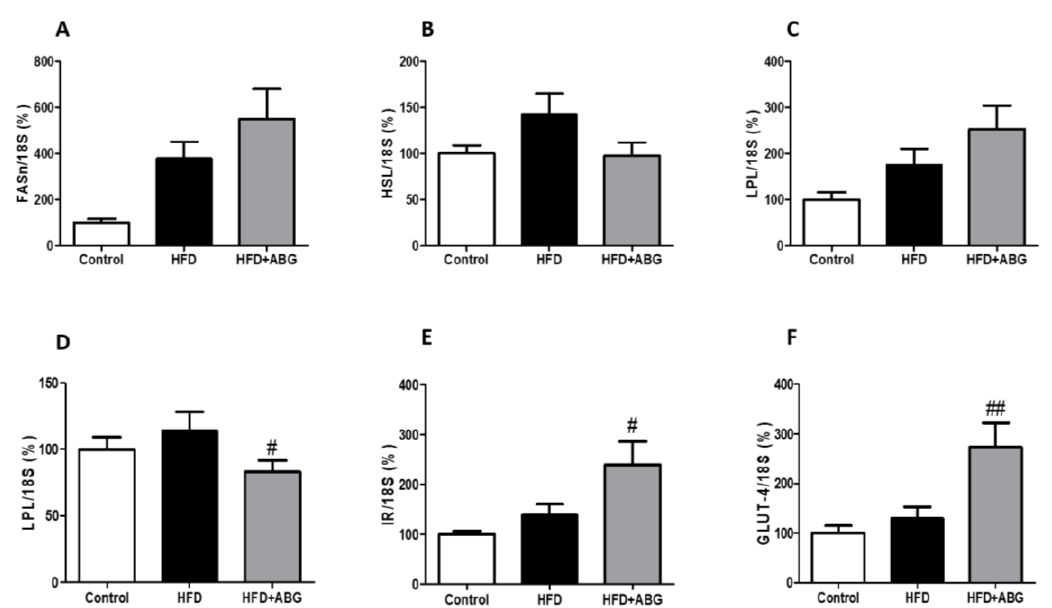
Figure 6. mRNA concentrations of fatty acid synthetase ( A ), hormone-sensitive lipase ( B ), lipoprotein lipase ( C ), peroxisome proliferator-activated receptor gamma ( D ), insulin receptor ( E ) and glucose transporter type 4 ( F ) in brown adipose tissue of rats fed a standard chow (control) or a high-fat diet (HFD)/high-sucrose diet and treated with vehicles or HFD + ABG. Data are represented as mean ± SEM; n = 8 samples/group. # p < 0.05 vs HFD; ## p < 0.01 vs HFD.